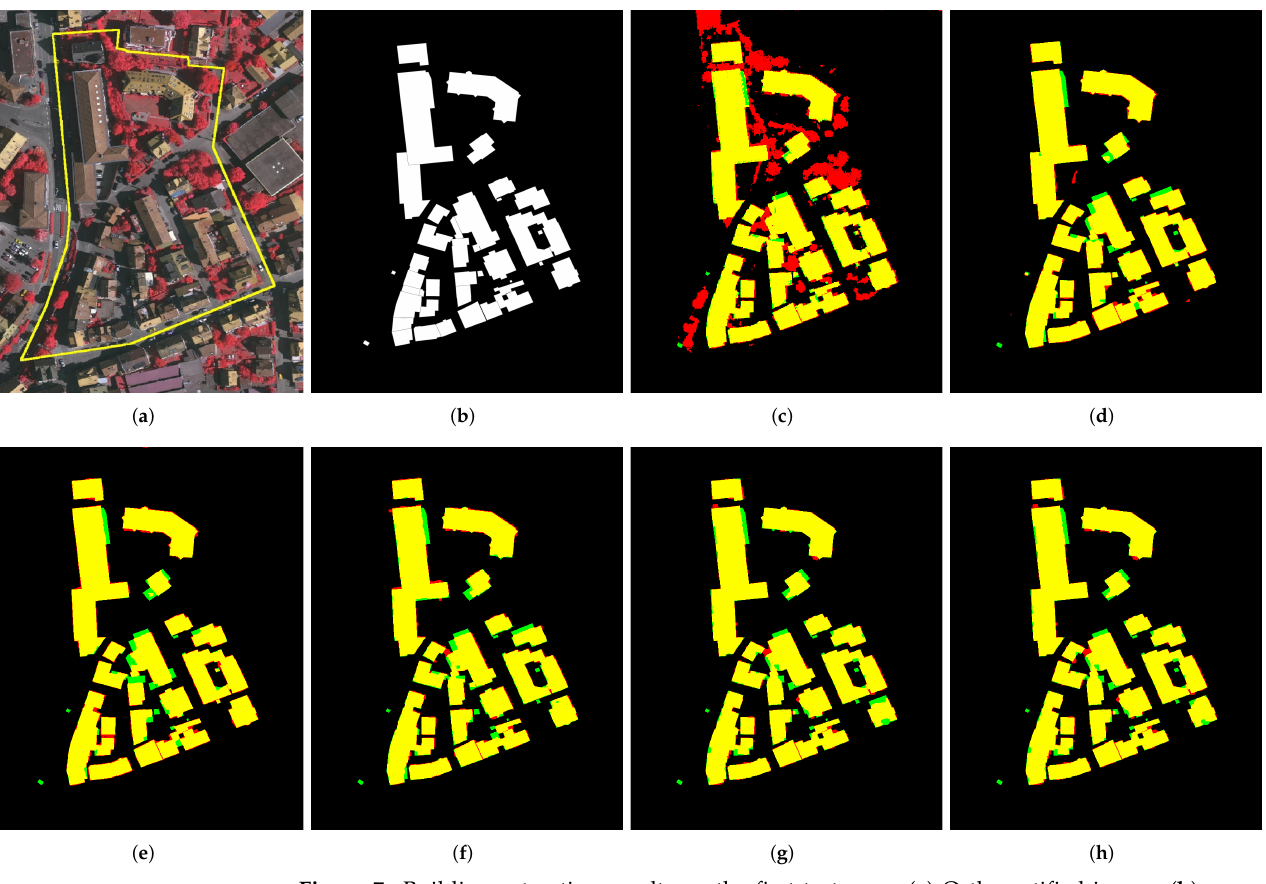
Figure 7. Building extraction results on the first test area. ( a ) Orthorectified image; ( b ) ground truth (white regions denote the buildings); ( c ) nDSM; ( d – h ): result of DeepLabv3+, U-Net, the HOA method, the beSH+IFCC method, and the biSH+IFCC